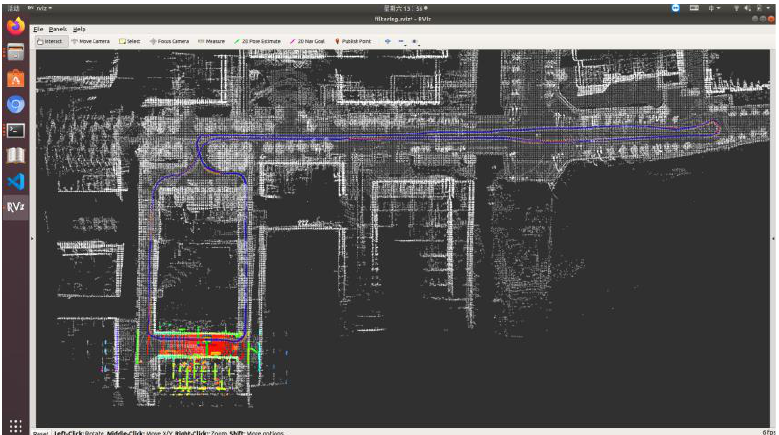
Figure 31. Field test NO.4. Two laps under curve driving scenario localization error in longitudinal, lateral, and altitude directions, respectively; the localization error is at the centimeter level.